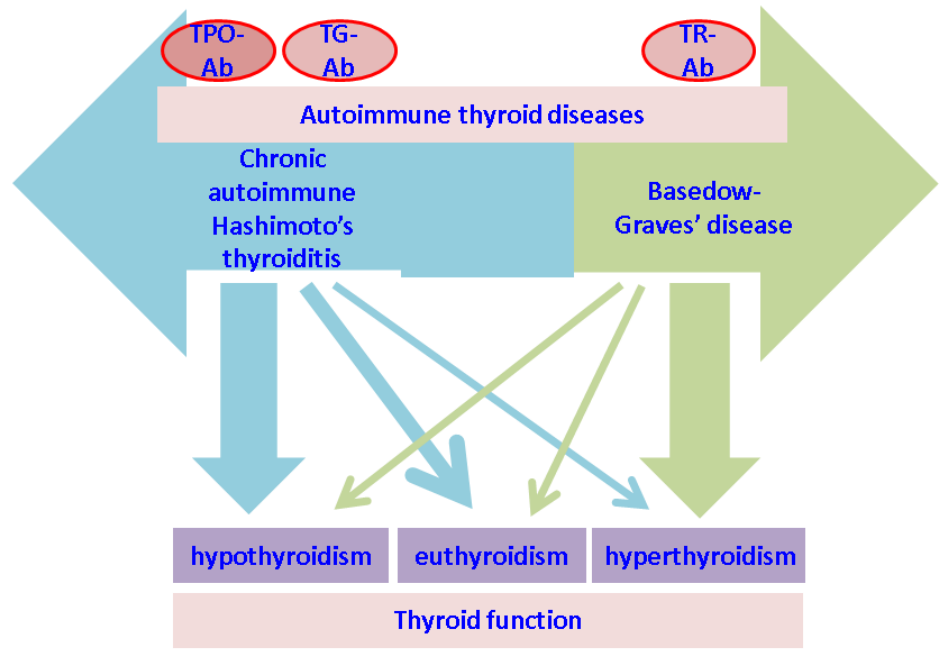
Figure 4. The relationship between thyroid hormonal profile and thyroid autoimmunity: Hashimoto’s thyroiditis and Graves’s disease belong to the spectrum of autoimmune thyroid diseases; most patients with Hashimoto’s thyroiditis have hypo or euthyroidism, but flare-up thyrotoxicosis might be present; Graves’s disease associates hyperthyroidism, however, normal thyroid function may be spontaneously or iatrogenic achieved while iatrogenic intervention (thyroidectomy, radioiodine therapy and anti-thyroid drugs) or copresence of blocking antithyroid antibodies causes hypothyroidism. Abbreviations: TPO-Ab = anti-thyroperoxidase antibodies; TG-Ab = antithyroglobulin antibodies; TR-Ab = TSH-receptor antibody.